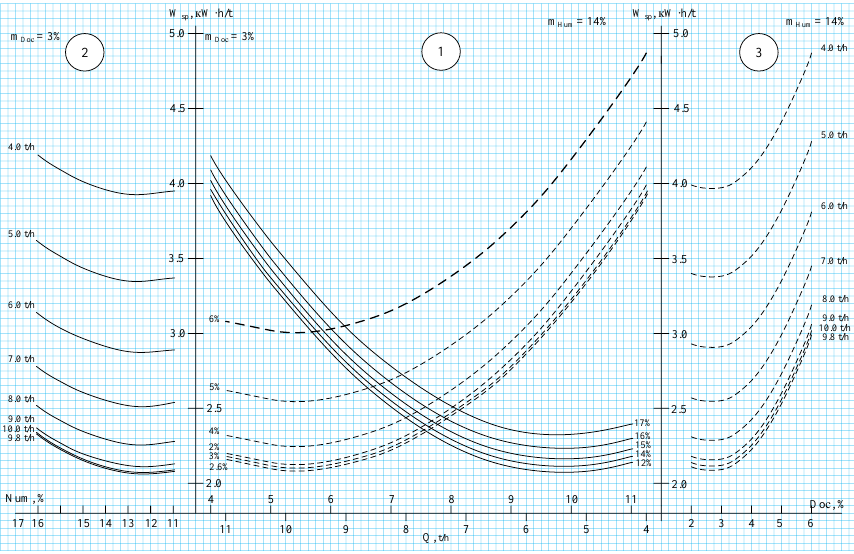
Figure 4. Nomograms of energy consumption for ZAV-20 (one production line without disc separators). By known values of humidity (Quadrant 2) and dockage of the grain (Quadrant 3) line is